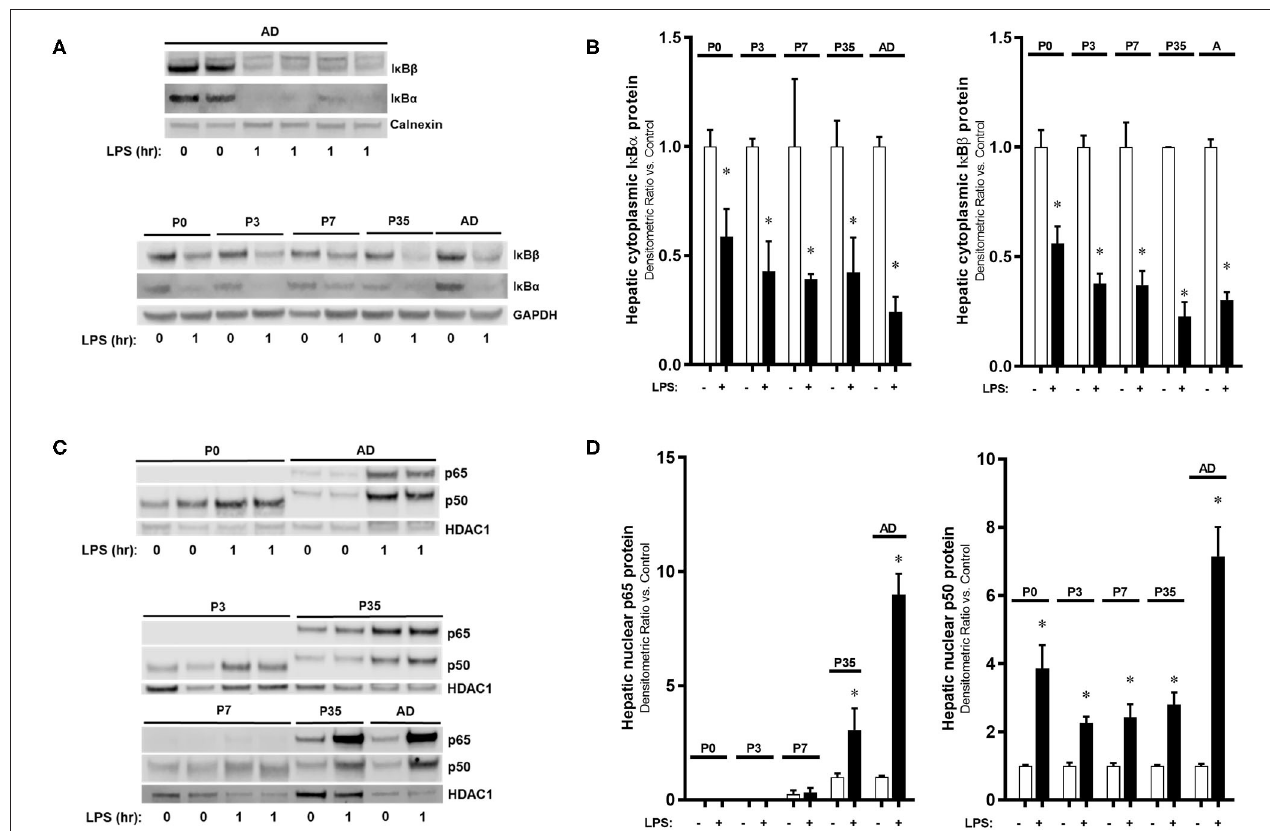
FIGURE 2 | The activation of the hepatic NF- κ B-mediated innate immune response to IP LPS is developmentally regulated by the subunit p65. IP LPS-exposed (5 mg/Kg, 1h) mouse livers (1h) from different developmental time points were collected and measured for hepatic (A,B) cytoplasmic NF- κ B inhibitory proteins I κ B α and I κ B β , and (C,D) nuclear p65 and p50 protein expressions. Loading controls used were calnexin and GAPDH (cytoplasmic), and HDAC1 (nuclear). * P < 0.05 vs. control (0h) by Student’s T -test. Values are represented as fold change relative to control.